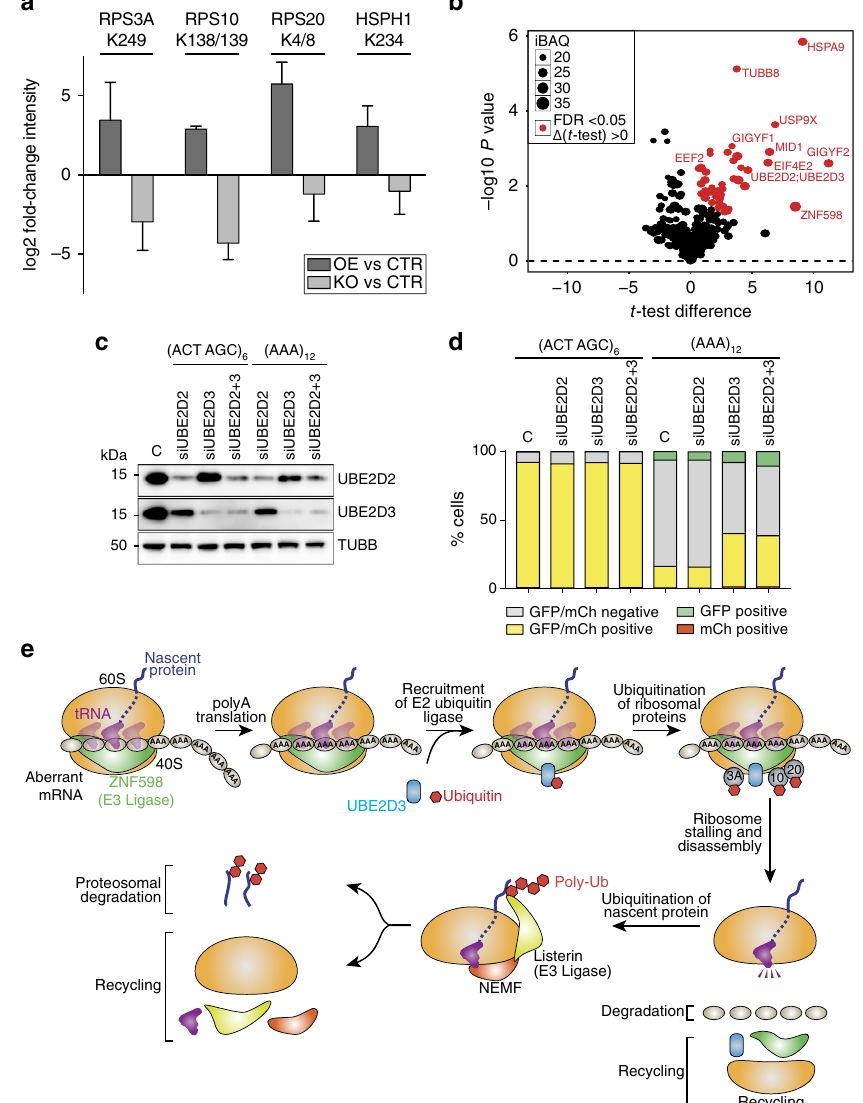
Figure 4 | Ribosome stalling at coding polyA sequences requires the E3 ubiquitin ligase activity of ZNF598 and the E2 ubiquitin ligase UBE2D3. ( a ) Identification of differentially ubiquitinated proteins by ubiquitin remnant immuno-affinity profiling. Log2 ratios of the enrichment of the quantified diGly-containing peptides are shown. Only peptides with an average log2 Z 2 upregulation for ZNF598OE/CTR and downregulation for ZNF598KO/CTR are shown. Error bars represent the s.d. ( n ¼ 2). See Supplementary Data 5 for a complete list of all detected peptides. ( b ) Volcano plots of the quantitative proteomic analysis of the ZNF598 interactome. The t -test difference based on label free quantitation for each detected protein is plotted against the negative logarithmic P value of a Welch’s t -test. The intensity based absolute quantitation (iBAQ) 51 values correspond to the sum of all the peptide intensities divided by the number of observable peptides of a protein and are represented by point size. Proteins with a permutation-based FDR-value of o 5% and t -test difference 4 0 are labelled in red and represent putative ZNF598 interactors (see also Supplementary Fig. 15 and Supplementary Data 6). ( c ) Analysis of siRNA-mediated knockdown of UBE2D2, UBE2D3 or both UBE2D2 and UBE2D3 in HEK293 cells by western blot. C indicates mock transfection. ( d ) Detection of GFP and mCherry fluorescent signals by FACS analyses in samples from ( c ), for reporter constructs containing (ACT AGC) 6 and (AAA) 12 linkers. Each experiment was performed in triplicate. ( e ) Model for ZNF598-dependent ribosome stalling and RQC at cryptic polyadenylated protein-coding